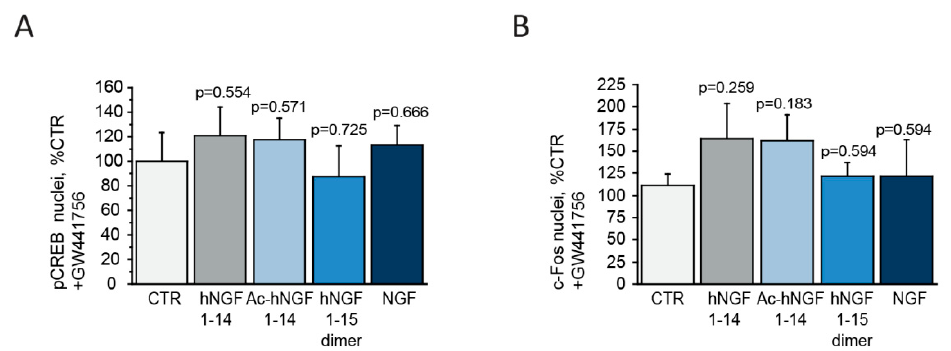
Figure 4. Effect of hNGF1–14 peptides on c-Fos and pCREB are abolished by a specific and potent TrkA inhibitor. ( A , B ) Quantitative analysis of pCREB and c-Fos positive nuclei in cholinergic neurons incubated for 60 ′ with 10 μ M scrambled hNGF1–14 (Scr), 10 μ M hNGF1–14, 10 μ M Ac-hNGF1–14, 10 μ M hNGF1–15 dimer and 100 ng/mL (3.84 nM) NGF following preincubation with the specific TrkA inhibitor GW441756 (15 μ M, 90 ′ ). Neurons were immunostained for pCREB or c-Fos and nuclei were counterstained with 4 ′ ,6-diamidino-2-phenylindole (DAPI) and visualized by epifluorescent microscopy. The number of pCREB and c-Fos immunolabelled nuclei was calculated as ratio over the total number of DAPI positive nuclei per field (20 × objective). Data are from n = 3 independent experiments and were expressed as percentage of CTR and reported as mean +SEM.